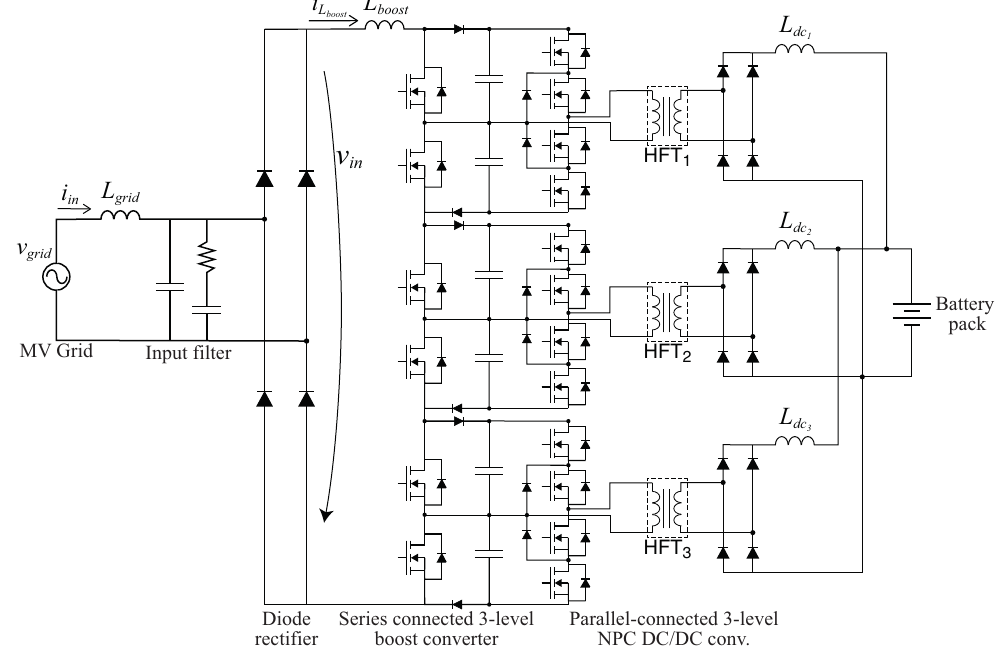
Figure 12. SST configuration used in [47] (figure adapted from